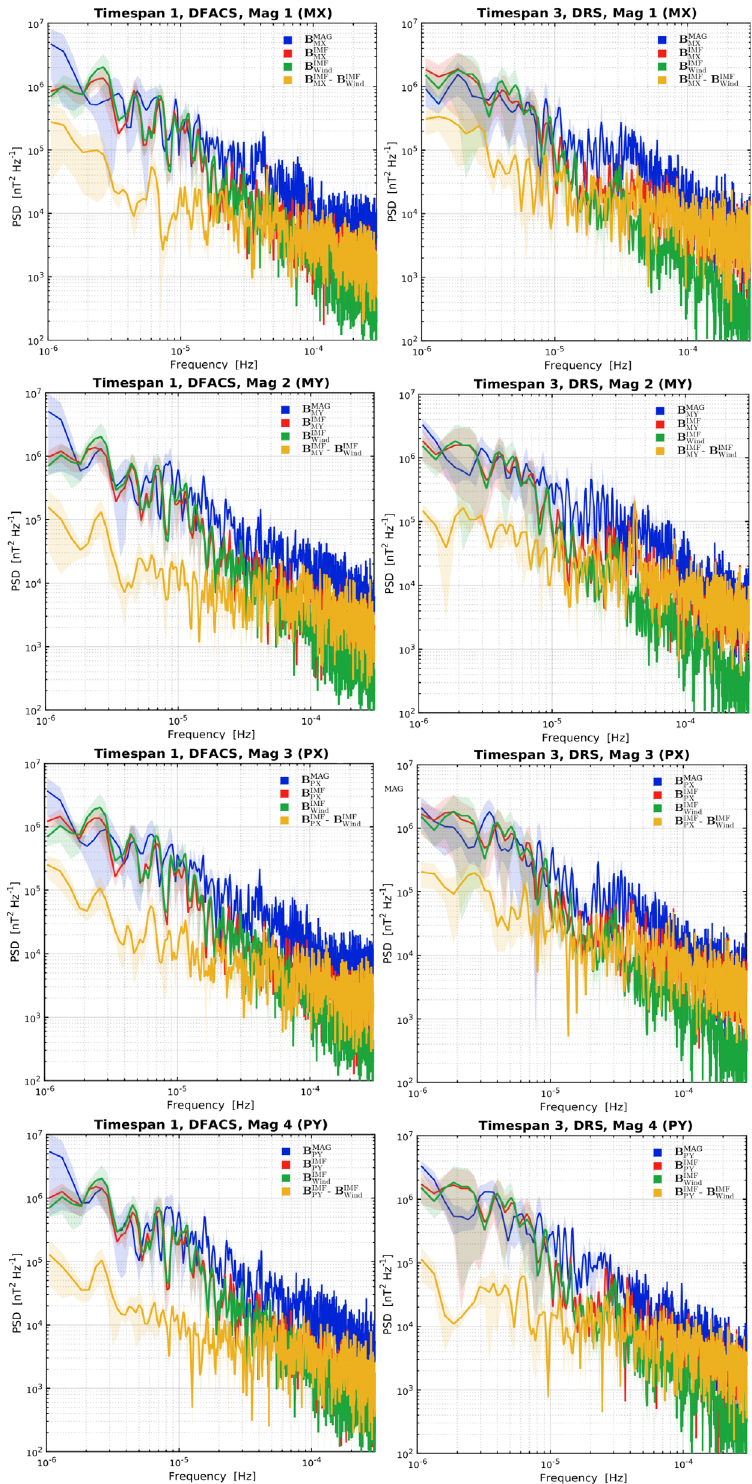
; B MAG , B MAG , B MAG ) and of the estimated IMF. Datasets refer to TS1 (left MX MY PX PY